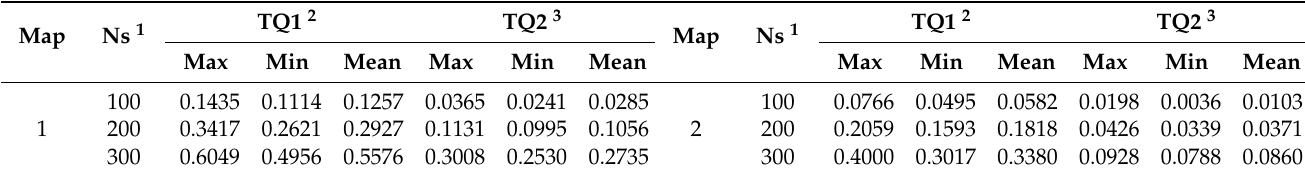
Table 2. Parameters of different query process in the single-channel environments.